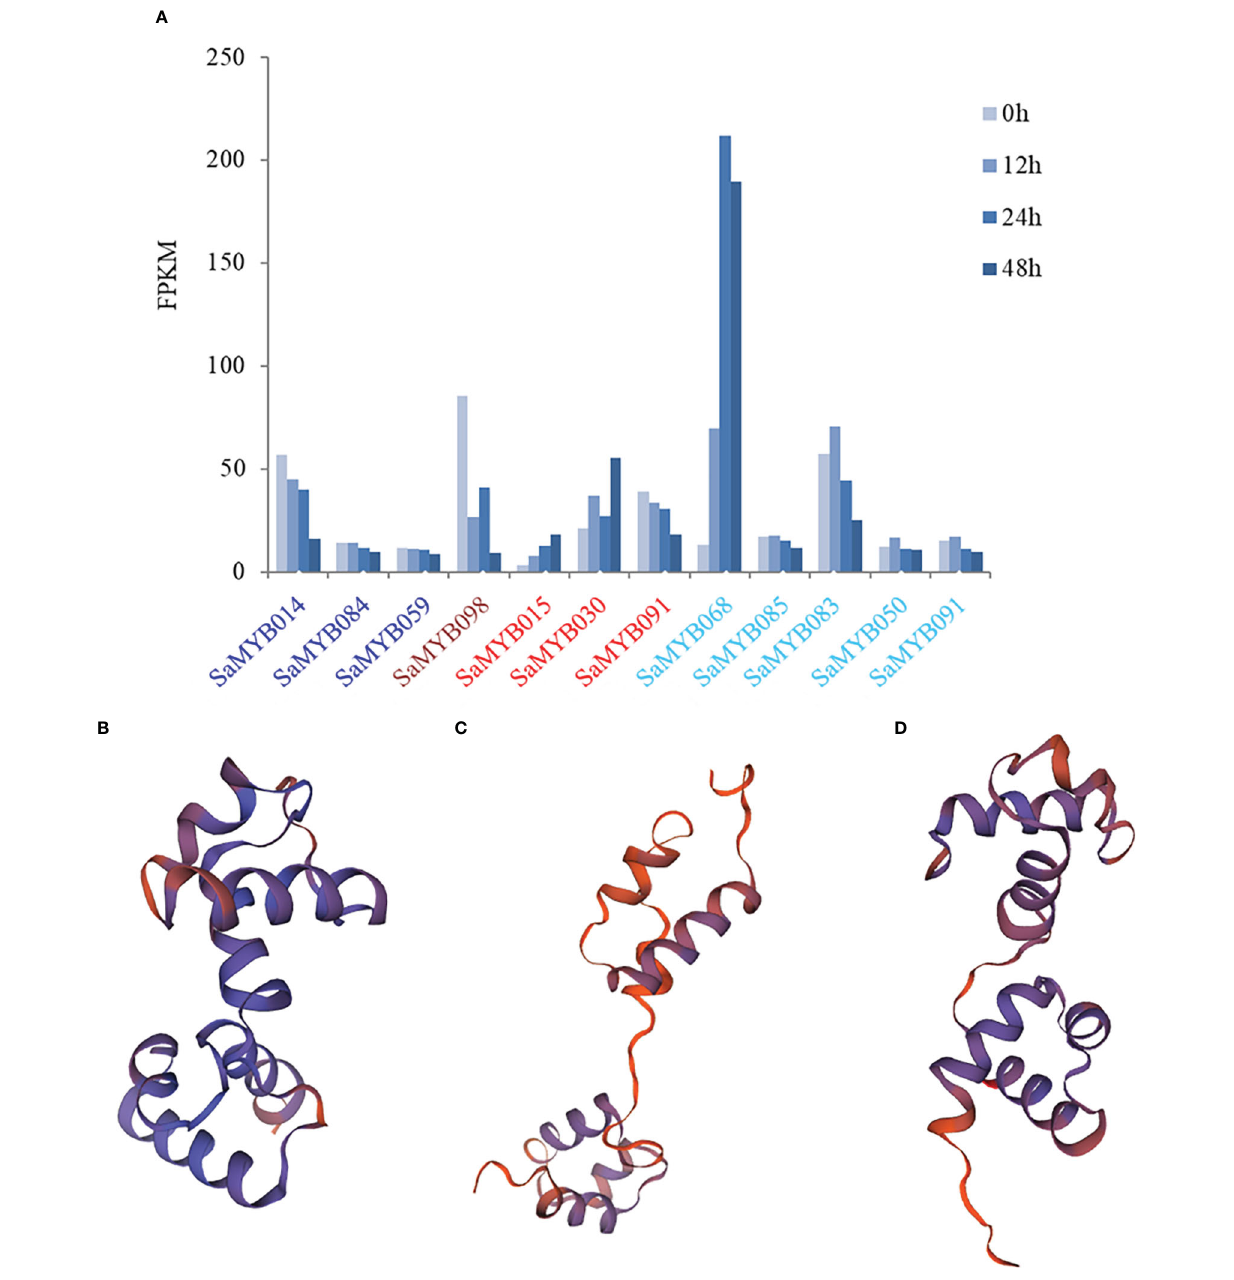
FIGURE 7 The expression patterns of module genes and the protein structure prediction results of the three important genes. (A) color of the text in the x -axis represents the corresponding module in same color in Figure 6. The y -axis represents the gene expression level; (B) the prediction result of protein spatial structure of SaMYB098 ; (C) the prediction result of protein spatial structure of SaMYB01 ; (D) the prediction result of protein spatial structure of SaMYB068